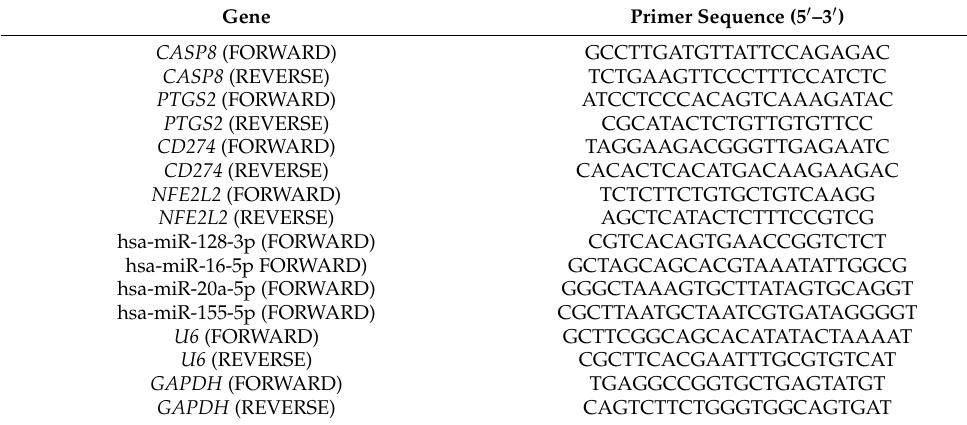
Table 1. Fluorescent primers for